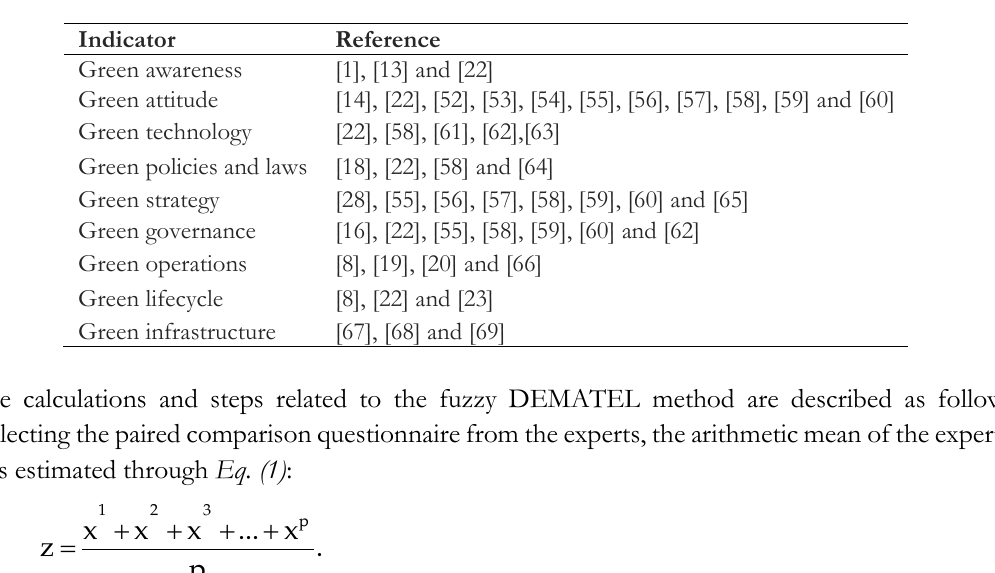
Table 3. Factors affecting green business process management readiness (extracted from the